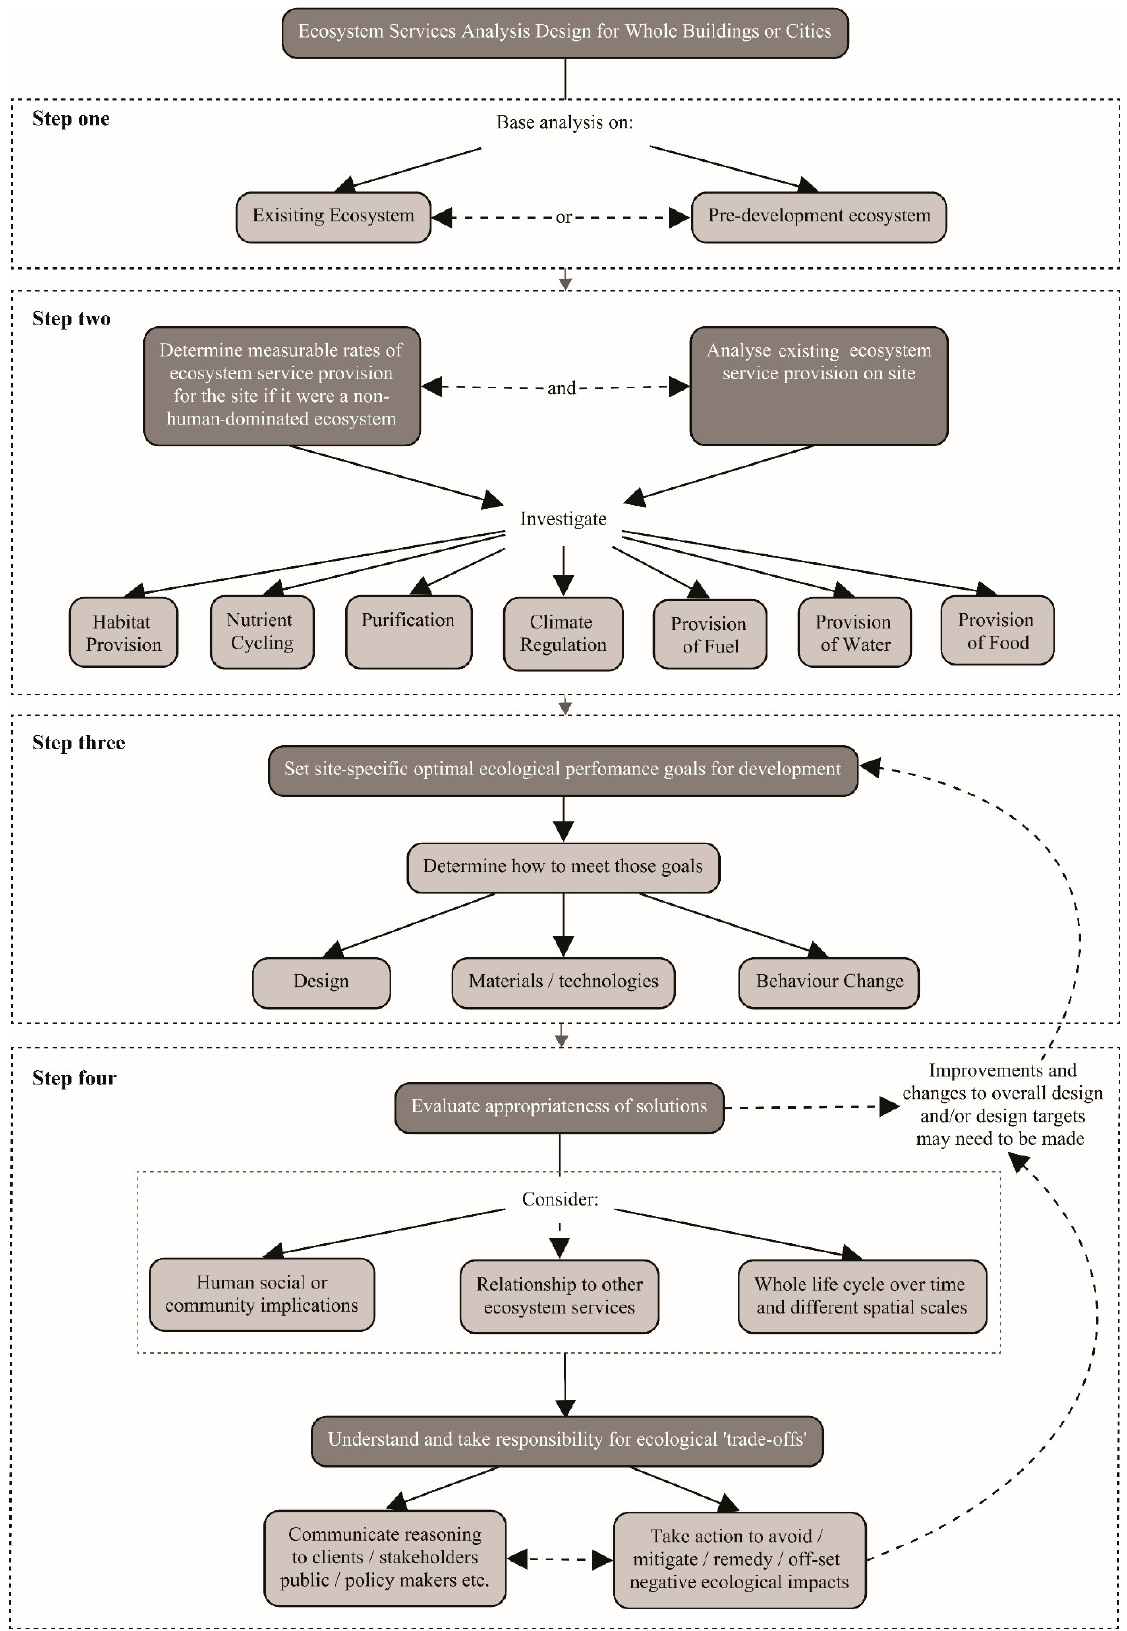
Figure 1. Ecosystem services analysis process (source: Pedersen Zari [11]).